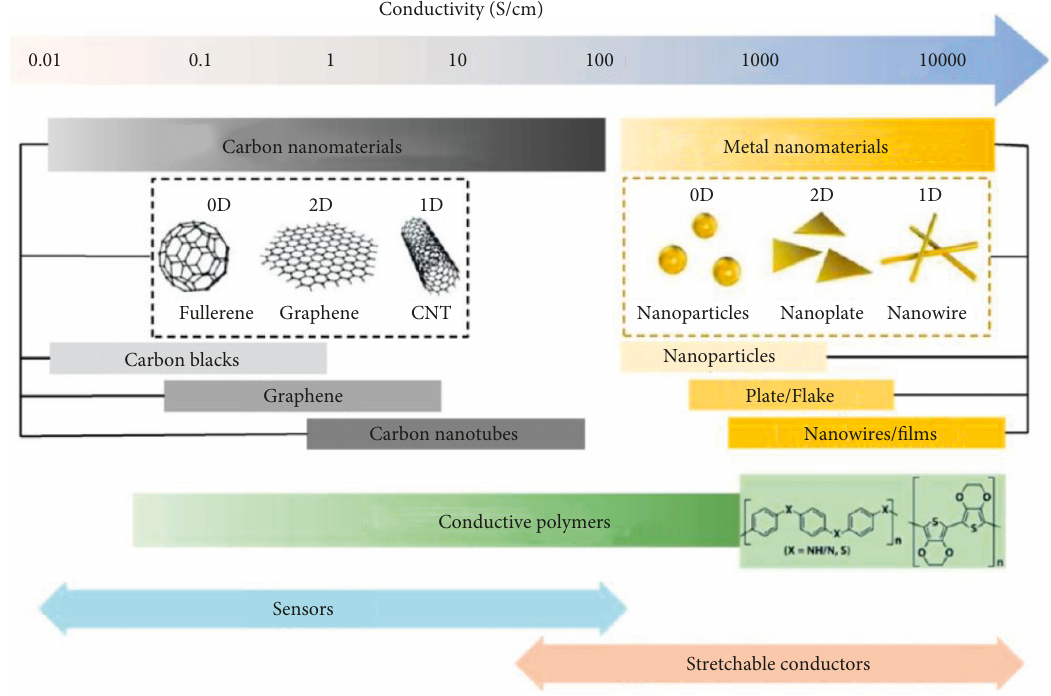
Figure 4: Conducting polymer with different carbonaceous nanomaterials and their advanced applications